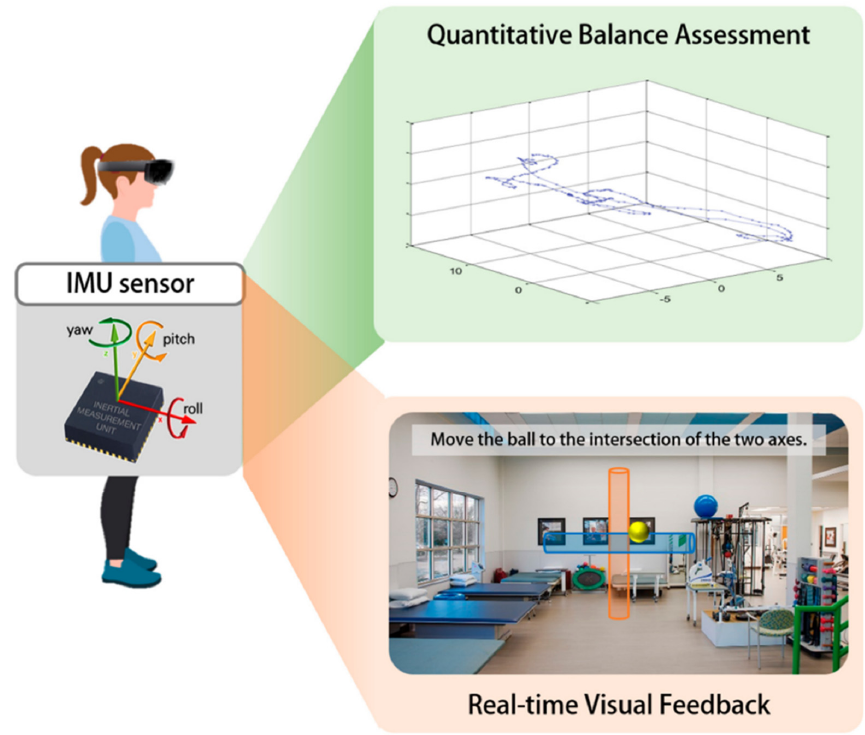
Figure 5. Conceptual diagram of an AR HMD-based rehabilitation management method that can support both therapists and patients [44] (IMU, inertial measurement